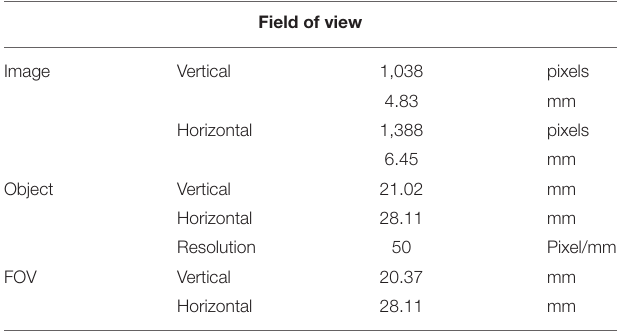
TABLE 1 | Dimensions of the CCD and object planes and the resulting field of view (FOV). Field of view